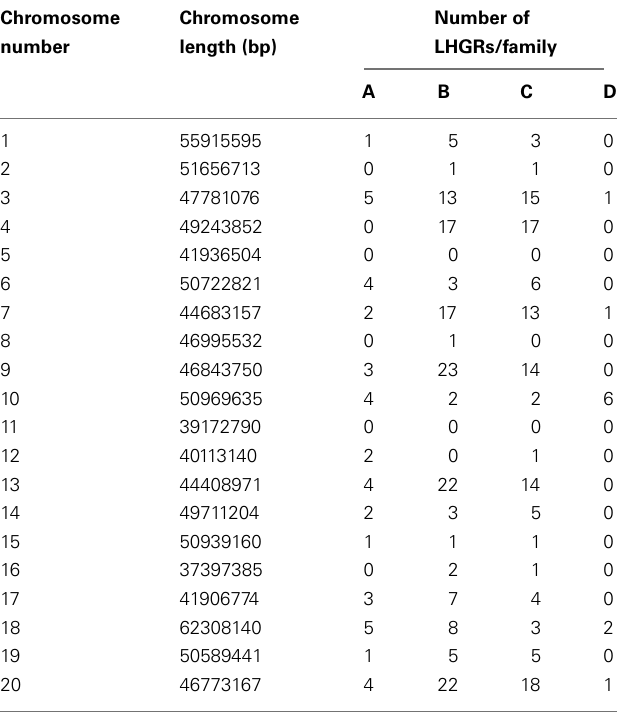
Table 2 |The number of LHGRs in each of the 20 soybean chromosomes and the length of the corresponding